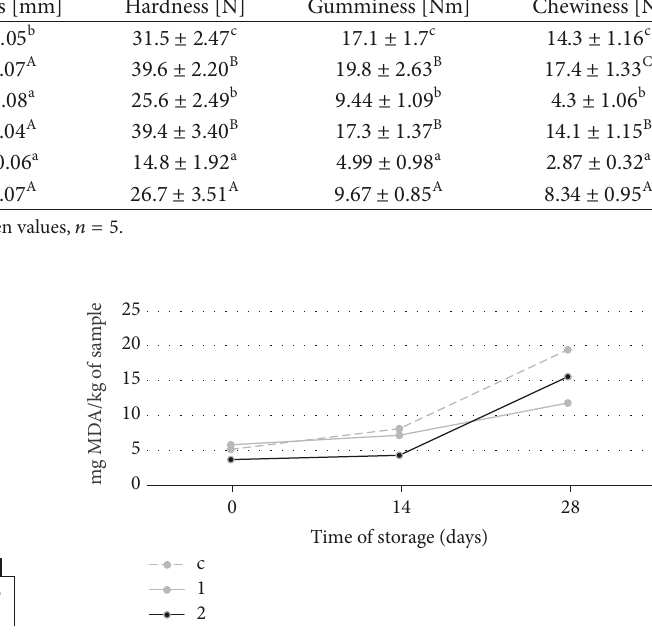
Figure 3: TBA values of meat